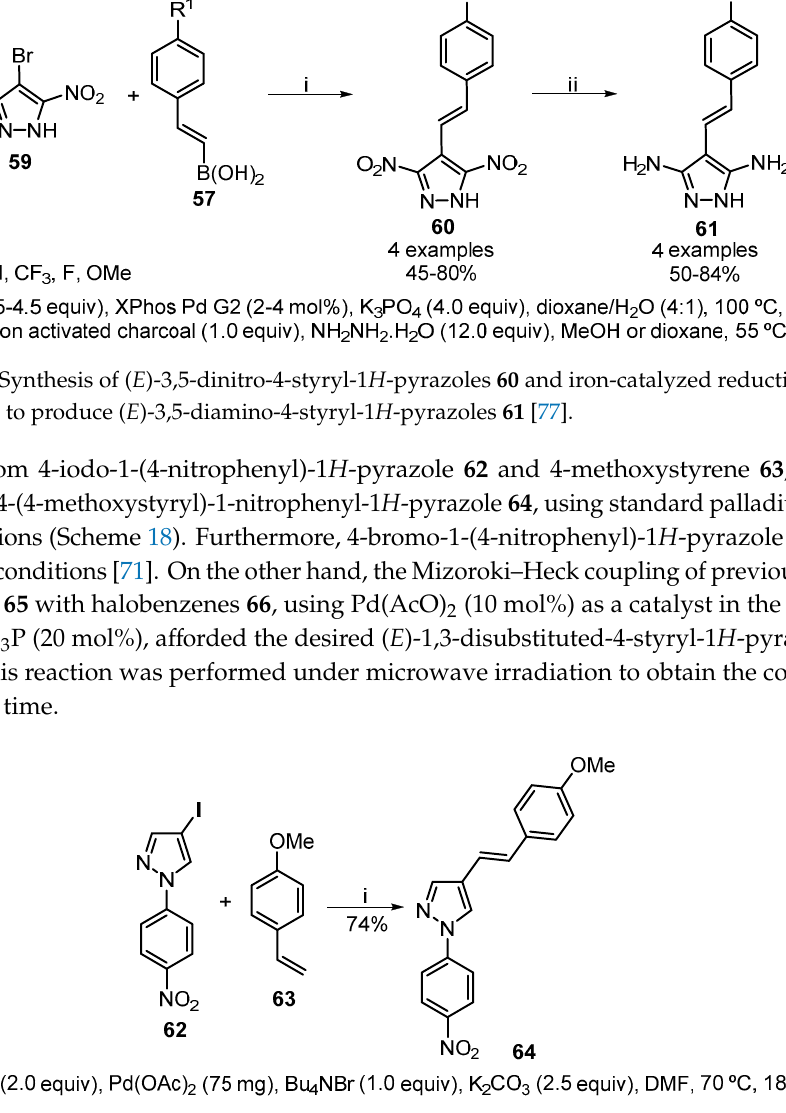
Scheme 18. Synthesis of ( E )-4-(4-methoxystyryl)-1-nitrophenyl-1 H -pyrazole 64 [71].